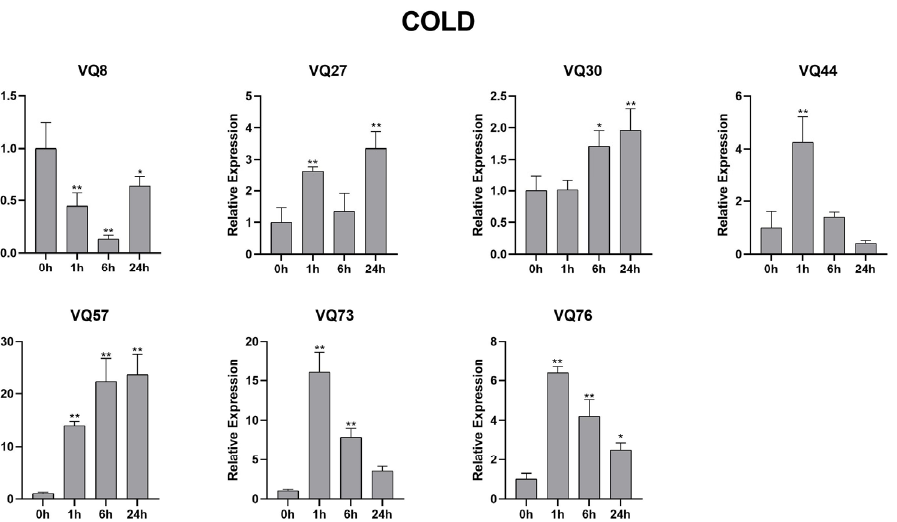
Figure 10. The expression profiles of seven selected VQ genes in response to cold stress. Plants were treated with cold (4 ◦ C) stress for 0, 1, 6 and 24 h. The 25s-RNA gene was used as the internal control and to normalize expression data. Relative transcript abundance was normalized relative to the expression of CK at 0 h. The 2 − ∆∆ Ct method was used to calculate the expression of target genes at different times and treatments. Error bars represented the standard deviation of the mean. * means p < 0.05, ** means p < 0.01.